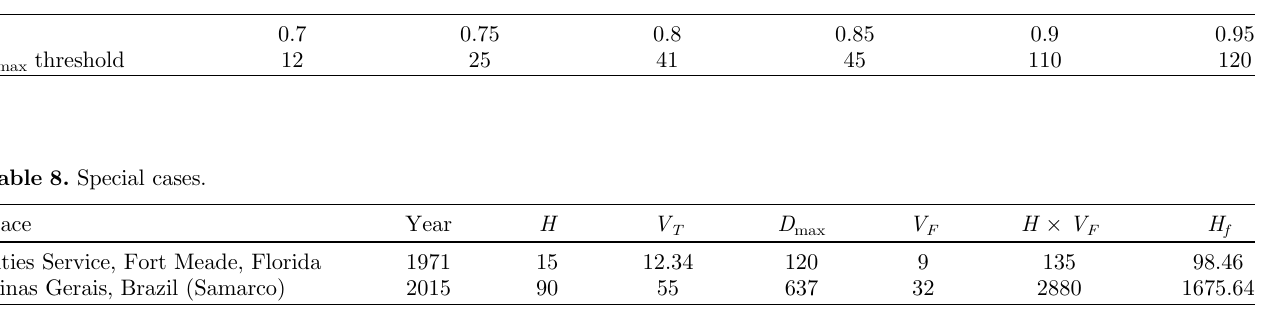
Table 7. Relation between v and the D max